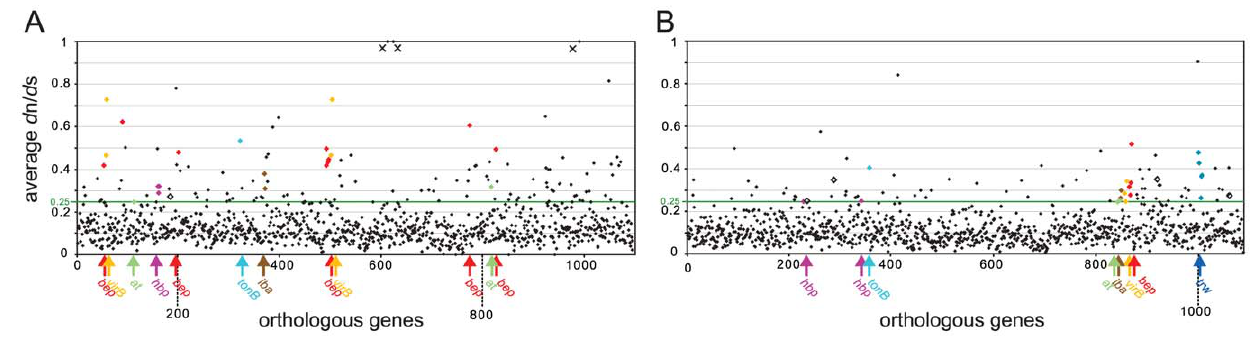
Figure 2. Gene-wide d n/ d s analysis of the core genomes of the two radiating lineages. d n/ d s analysis for lineage 3 (A) and for lineage 4 (B). The mean values plotted on the y-axis were obtained from the d n/ d s values of pairs of orthologs. Genes are ordered according to their position in the genome of Bc (A) and Bq (B). Genes with elevated d n/ d s values homologous to known colonization factors of Bartonella (based on previously published results [16,43–45]), are depicted by colors. at , putative autotransporter, bep , Bartonella effector protein, hbp , hemin-binding protein, iba , inducible Bartonella autotransporter, virB , VirB T4SS protein, trw , Trw T4SS protein. Genes encoding hypothetical proteins known to be important for colonization are depicted by open black squares (one in lineage 3, four in lineage 4). In lineage 3, three genes exhibit average d n/ d s values & 1 (marked by crosses). This is explained by the fact that between Br and B 1-1C, only non-synonymous mutations but no synonymous mutations have been detected in these three genes. As all three genes revealed v , 1 in the other pair-wise comparisons, they were treated as outliers and excluded from further analysis.